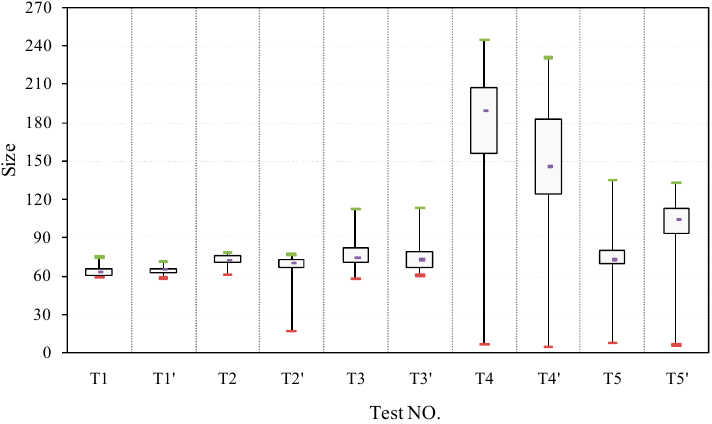
Figure 3. Colloidal silica size distributions under different conditions. Colloidal silica particle size is the value of the normalized column effluent suspension after two pore volumes.